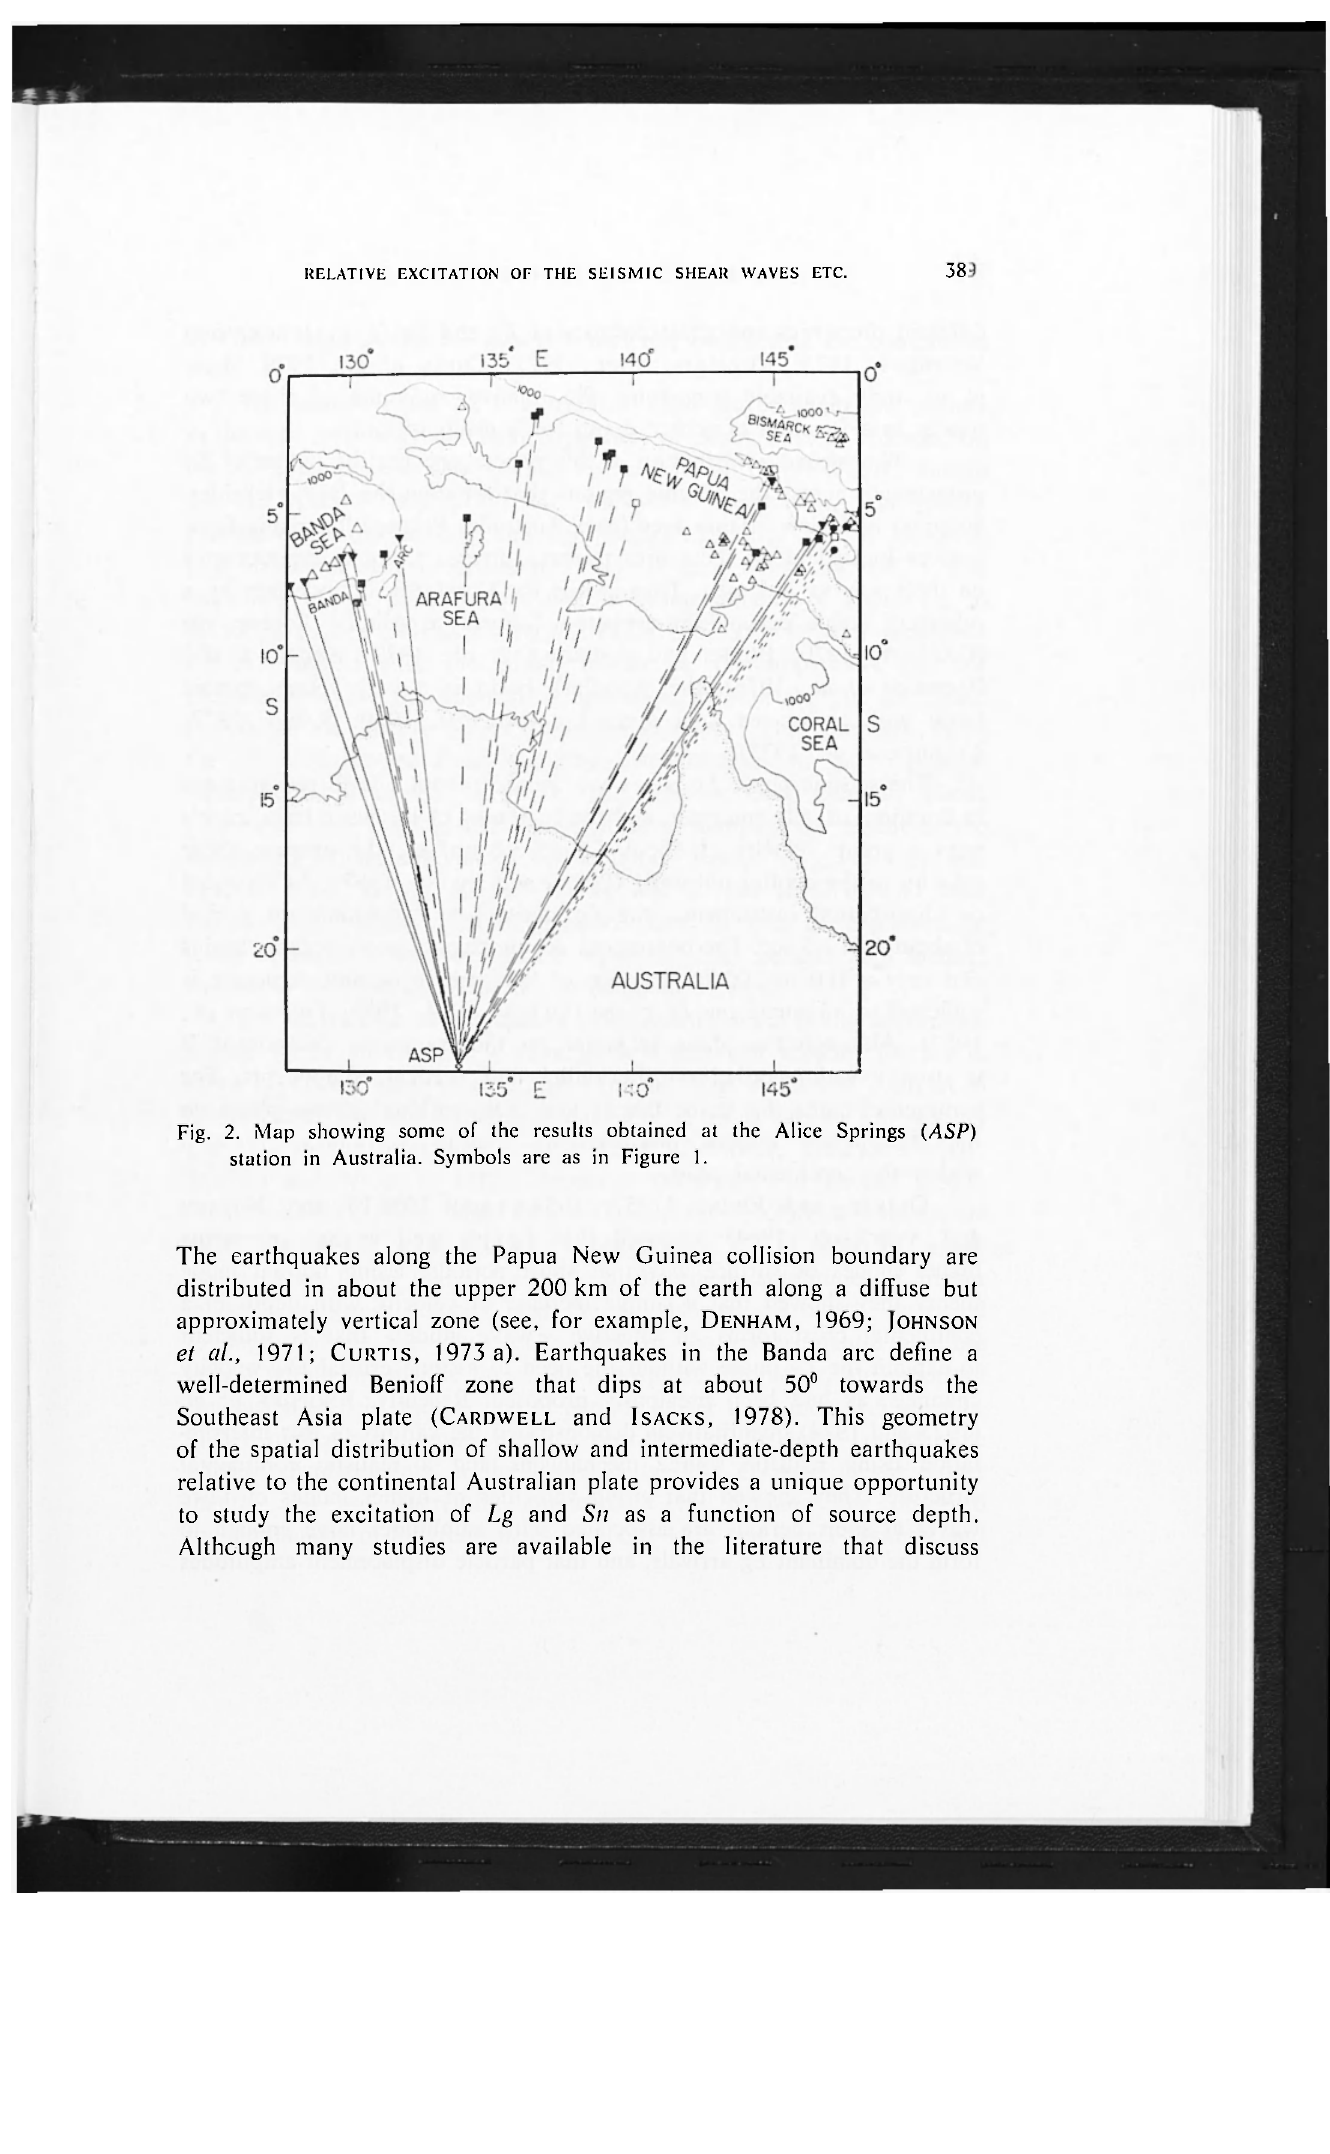
Fig. 2. Map showing some of the results obtained at the Alice Springs {ASP) station in Australia. Symbols are as in Figure